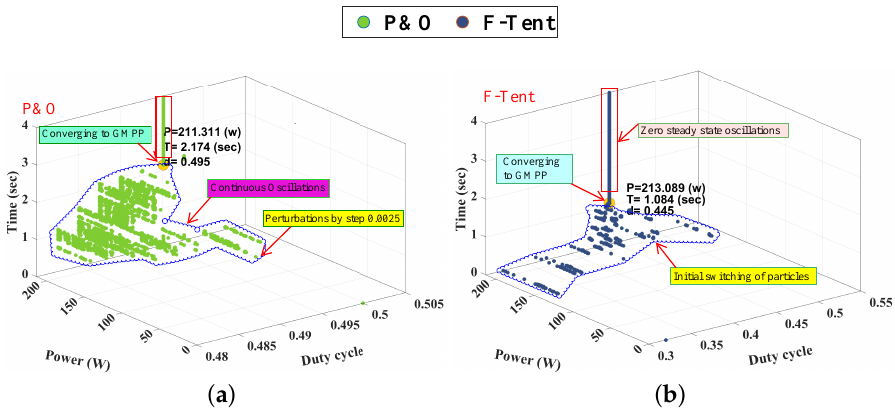
Figure 9. The obtained power and duty cycle by the P&O and the fractional tent map for pattern 5 in the case of 4S2P of SM55 PV array reconfiguration: ( a ) P&O, and ( b ) F-tent map with